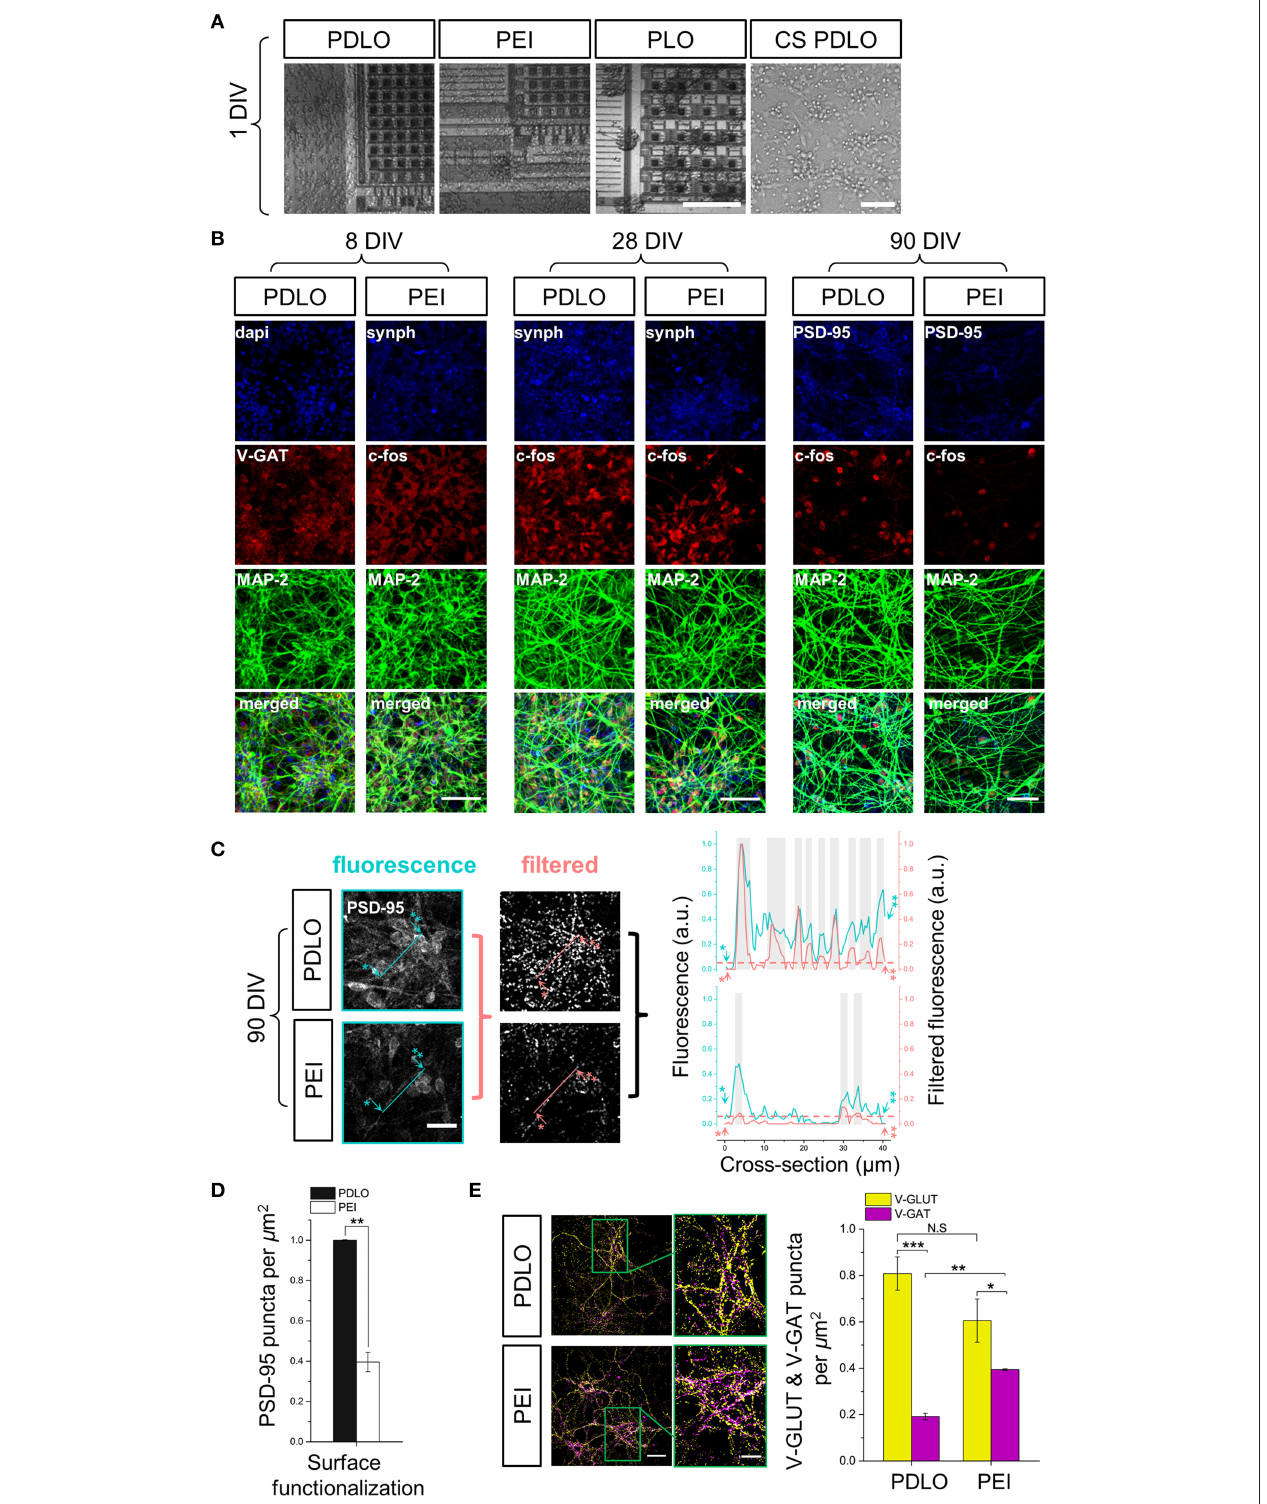
FIGURE 2 | Optical read-outs allow to track the development of human iCell neuronal networks over 3-month culture and to discriminate the effects of biochemical adhesion molecules on neuronal growth and function. (A) Fluorescence images elucidate differences in neuronal growth after 1DIV